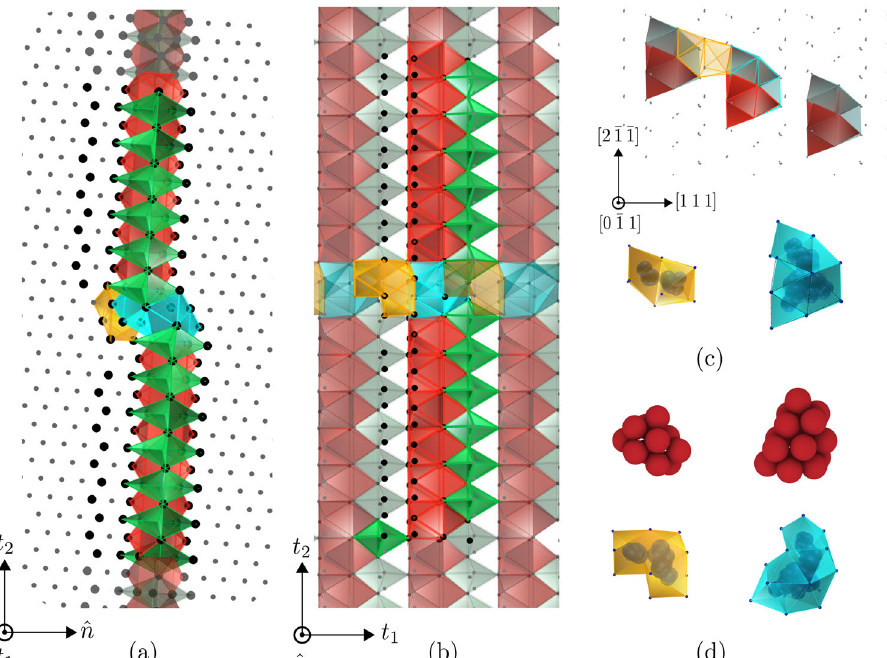
Fig. 11 The polyhedral unit model of the Σ 3 ð 945 Þ asymmetric tilt GB is illustrated. a , b The atomistic structure along with the polyhedral units ! ! ¼ ½ 111 (cid:5) is the tilt axis, ^ n ¼ ½ 945 (cid:5) is the BPl normal and t ¼ ½ 1 ; 14 ; 13 (cid:5) . This GB is vicinal to the Σ 3 ð 211 Þ symmetric are shown. The vector t 1 2 tilt GB. Therefore, it contains facets of the CTP units and two polyhedral units (colored in blue and orange) that are a part of the ledge in the vicinal GB. c The same GB is shown along the ½ 011 (cid:5) axis, without the dual-tetrahedral units, to emphasize the polyhedral units along the ledge. d The polyhedral units that belong to the ledge and the clusters of atoms that correspond to these units are